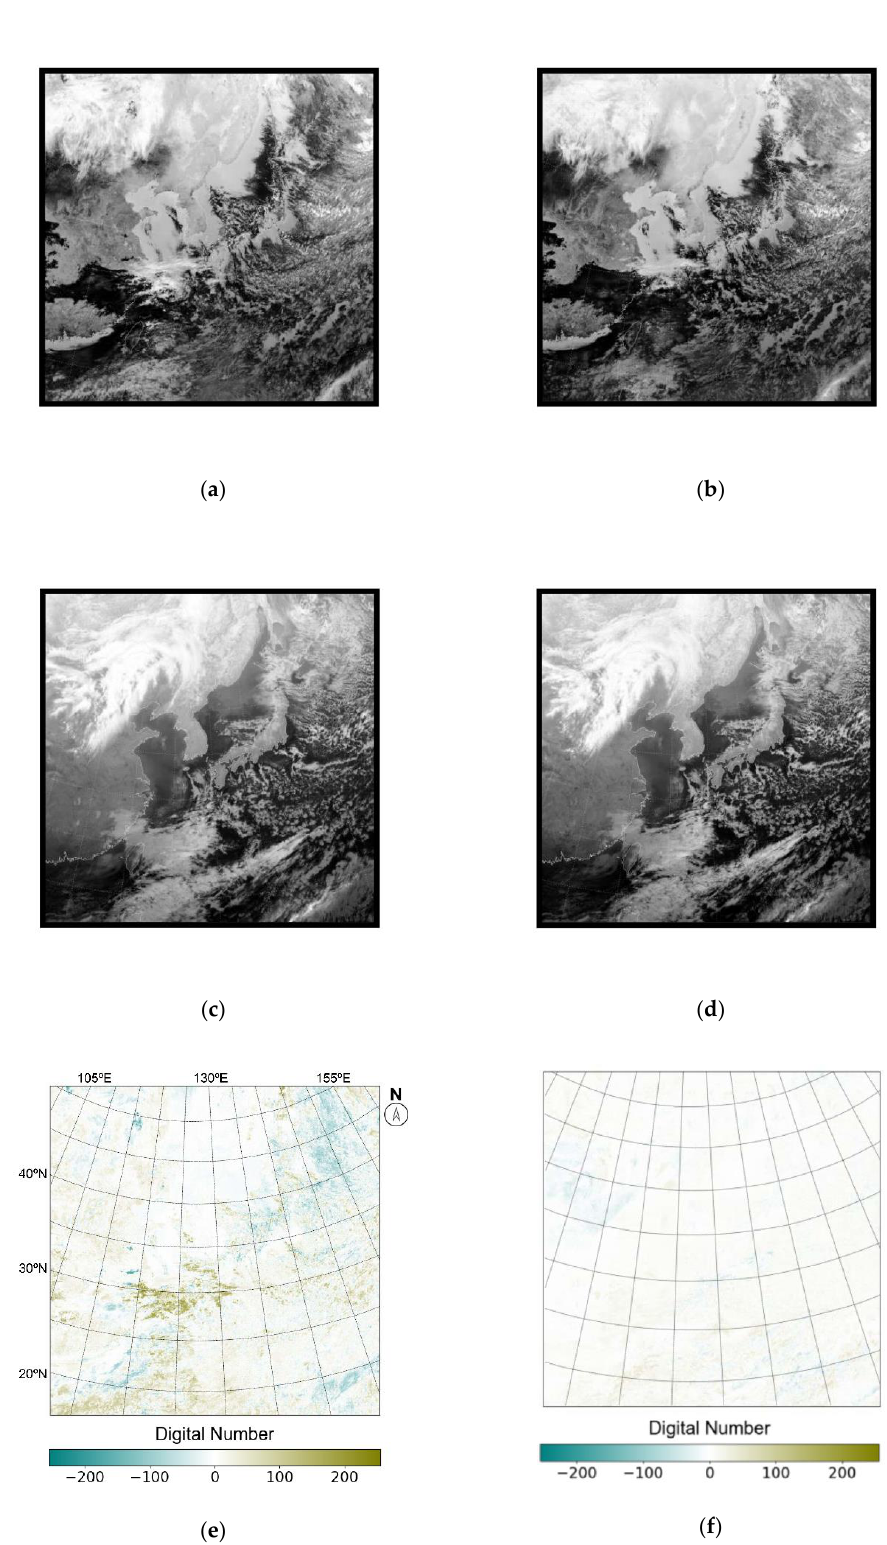
Figure 5. ( a ) Real COMS MWIR reflectance and ( b ) artificial intelligence (AI)-generated COMS MWIR reflectance on 25 January, 04:00 UTC (day time) with 40,000 iteration, ( c ) real COMS MWIR radiance, and ( d ) AI-generated COMS MWIR radiance on 25 January, 16:00 UTC (nighttime). ( e ) Di ff erence between ( a ) and ( b ), and ( f ) di ff erence between ( c ) and ( d ) are shown,